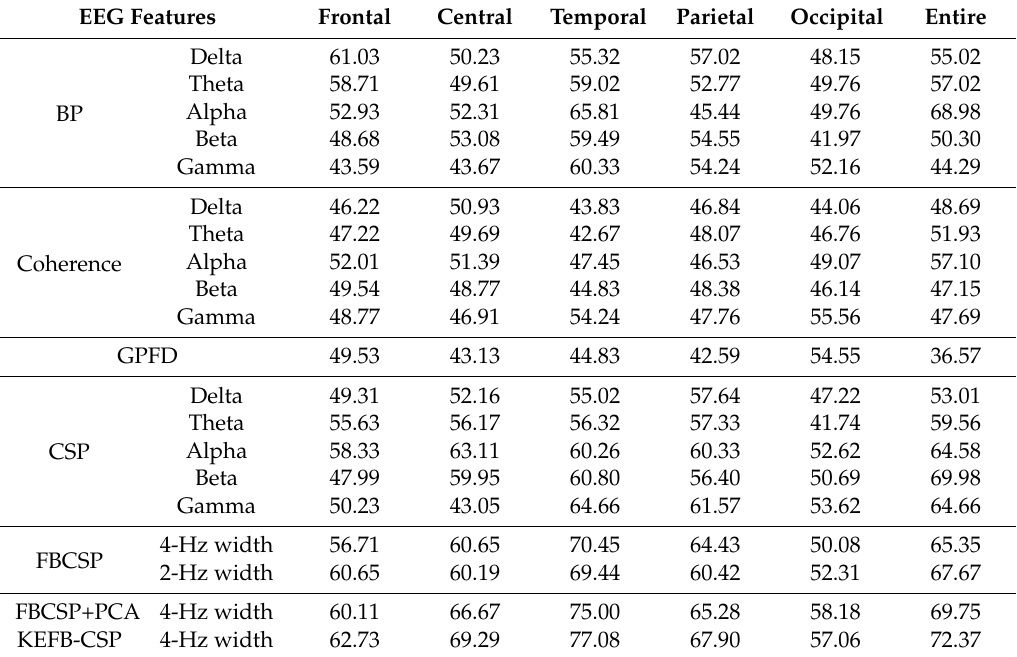
Table 4. Comparison of average classification accuracies over 54 trials of EEG signals among different features and scalp regions using k -NN classifier (in